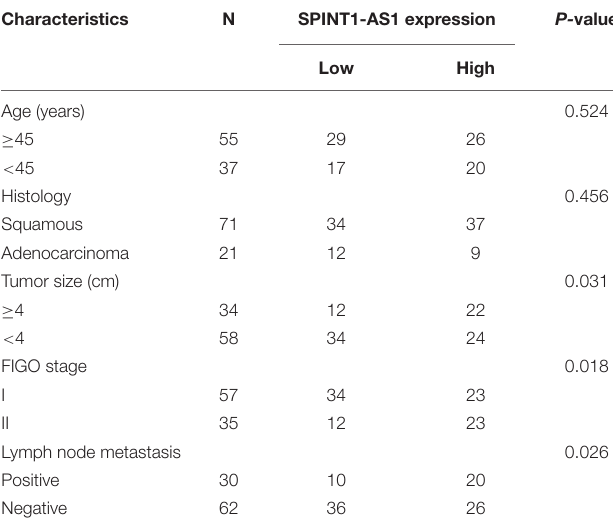
TABLE 1 | Correlation between SPINT1-AS1 expression and clinicopathological characteristics in 92 cases of cervical cancer.